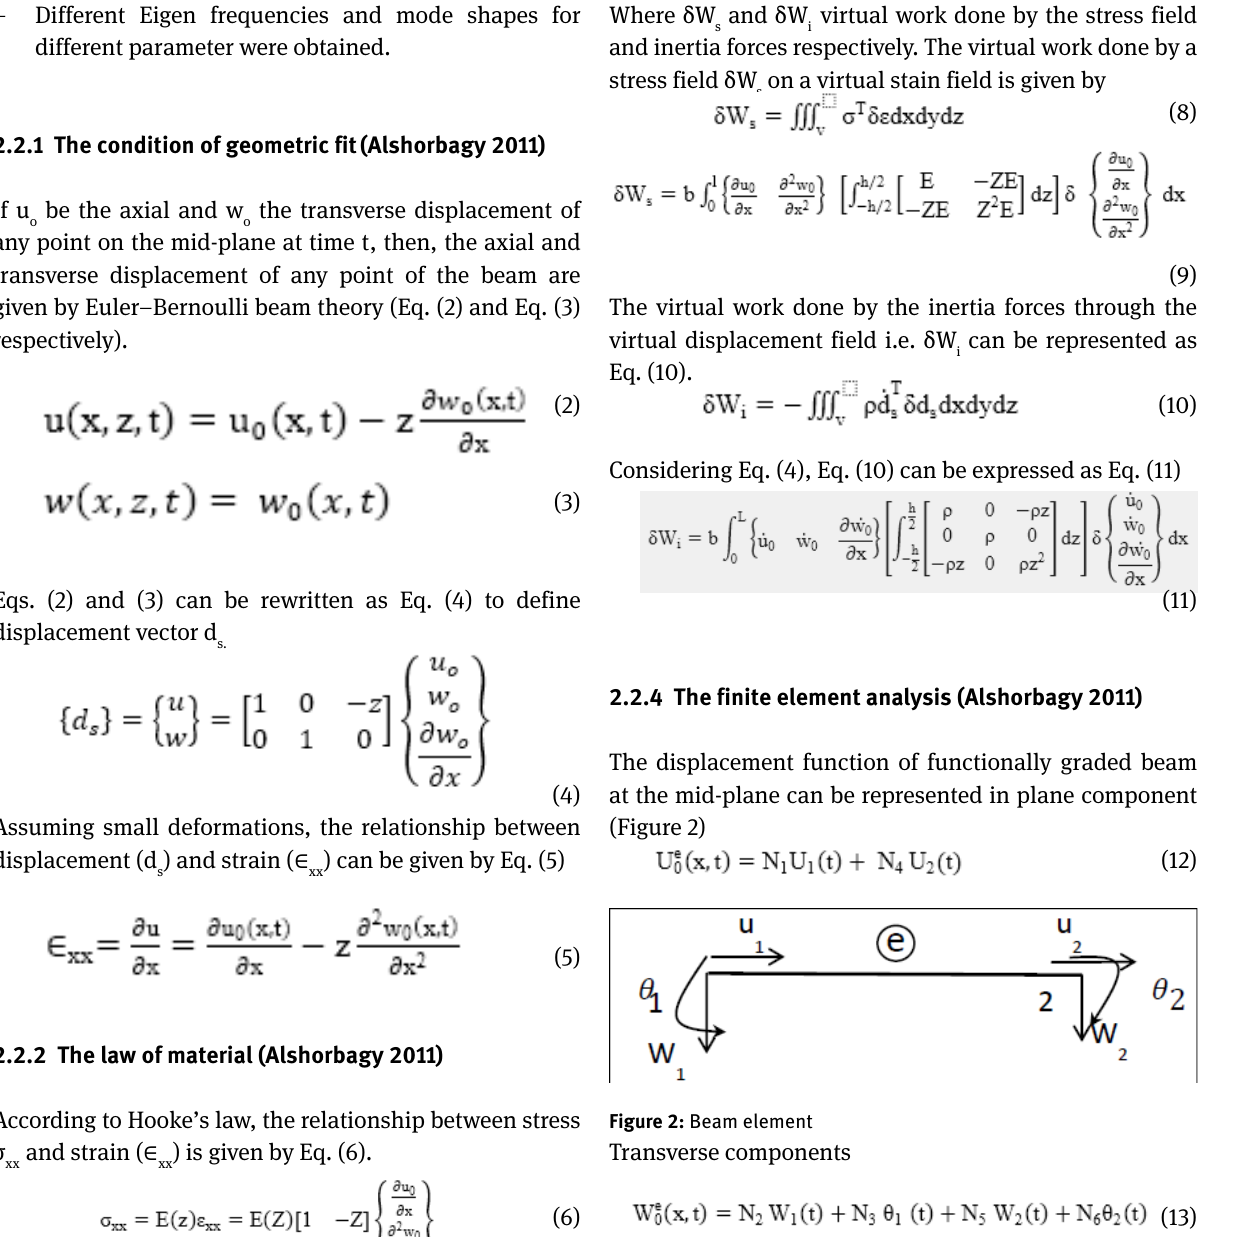
Where, N denotes the shape functions or interpolating